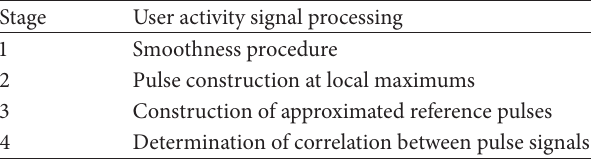
Table 1: Overview of the user activity modeling and analysis.